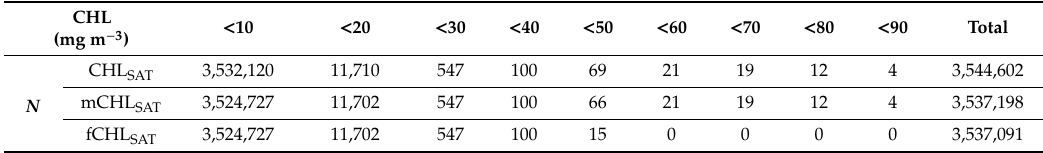
Table 2. Number of pixels at specific ranges of the chlorophyll-a concentration (CHL) on the remotely observed CHL (CHL SAT ), masked CHL (mCHL SAT ) and noise-filtered CHL SAT (fCHL SAT ) data from 2012 / 2013 to 2017 / 2018. The CHL data were masked in areas with SIC higher than 60%. The numbers in the brackets indicate the number of masked pixels. Most CHL values removed from the mCHL SAT data are concentrated the CHL range below 10 mg m − 3 , with the mean ± s.d. of approximately 0.20 ± 0.32 mg m − 3 . In contrast, the filtered CHL values on the fCHL SAT data are confined within the CHL range above 40 mg m − 3 and the 54.41 ± 11.94 mg m − 3